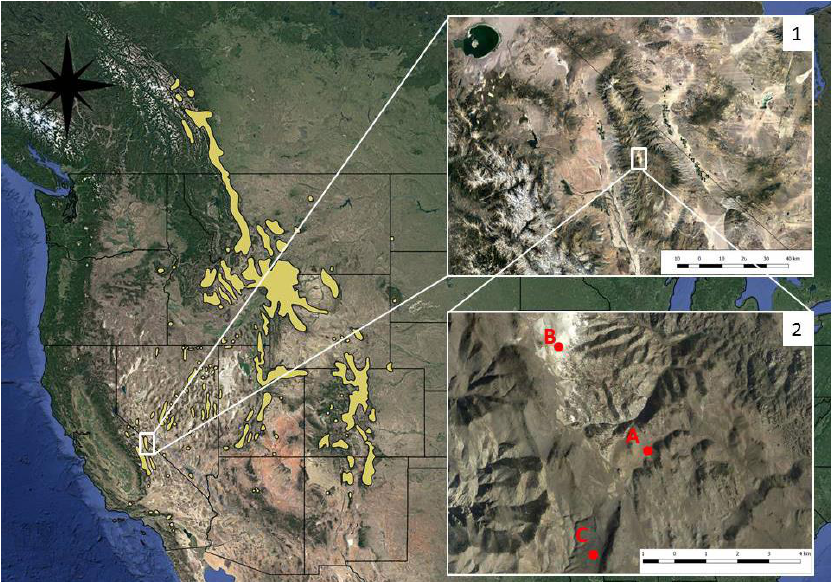
Figure 1. Map of the western United States showing the range of limber pine (yellow) and the White Mountains of California and Nevada, southeast of Mono Lake, where this study took place (Inset 1). Source location for granitic soil ( A ) and the source locations for dolomitic soil ( B ) and quartzite soil ( C ) are shown in red (Inset 2). The source for granite soil ( A ) is also the location of the Crooked Creek Station where the experiment took place. Maps were created in QGIS with Google base